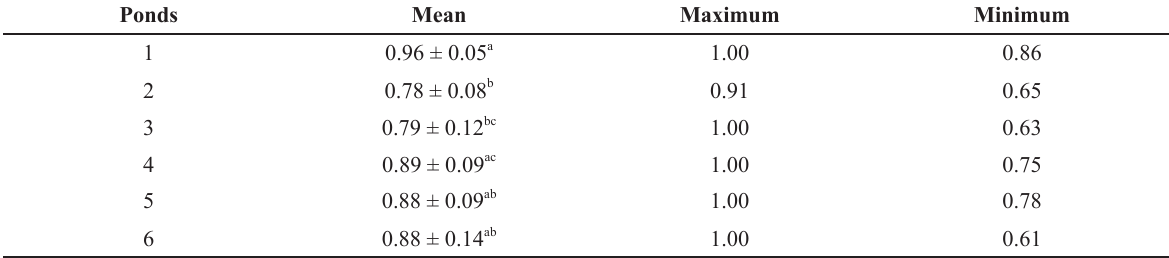
Means (± SD) of pure technical efficiency obtained through data envelopment analysis with variable returns to scale of the conventional system ponds in a farm located on the coast of Pernambuco, Brazil.